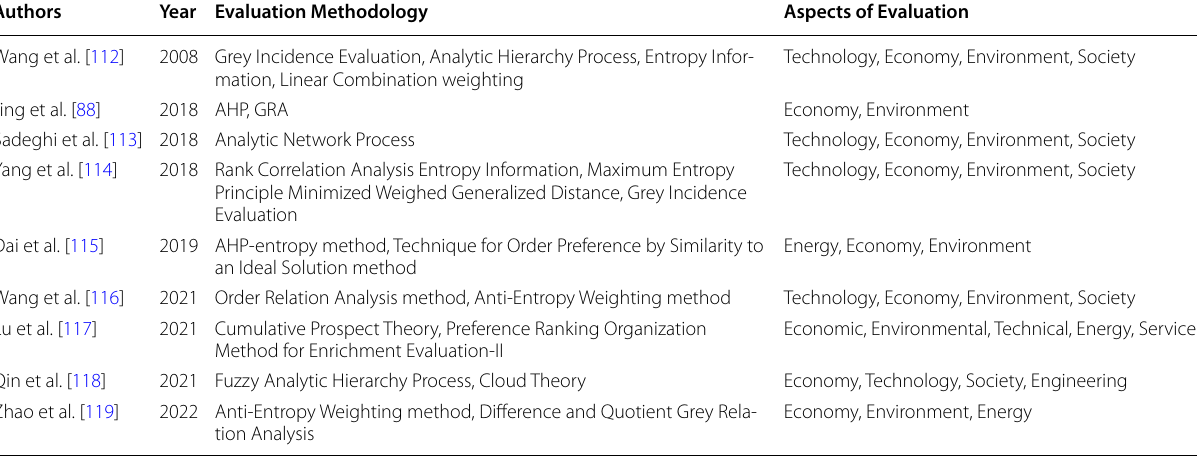
Table 2 Literatures on comprehensive evaluation methods for distributed energy systems